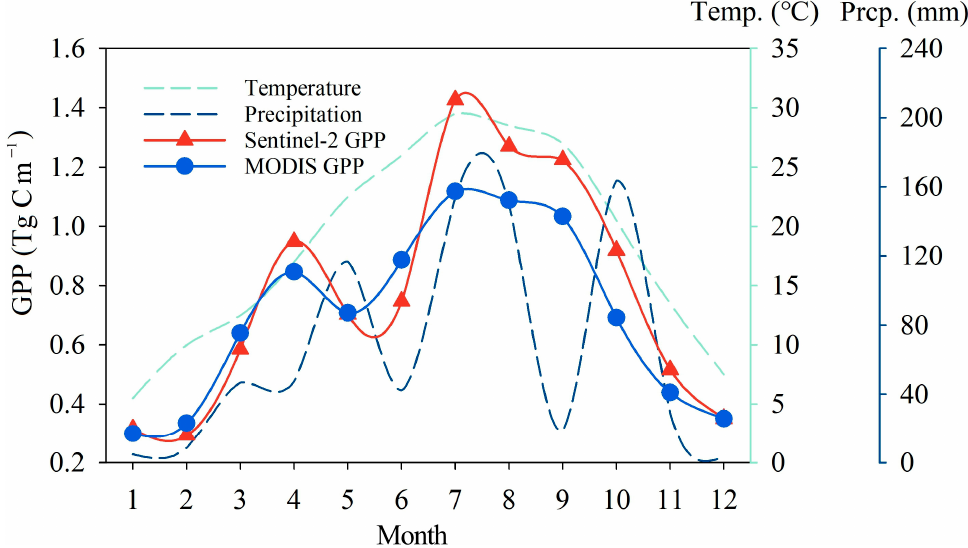
Figure 5. The monthly change of Suzhou’s GPP in the year 2021.